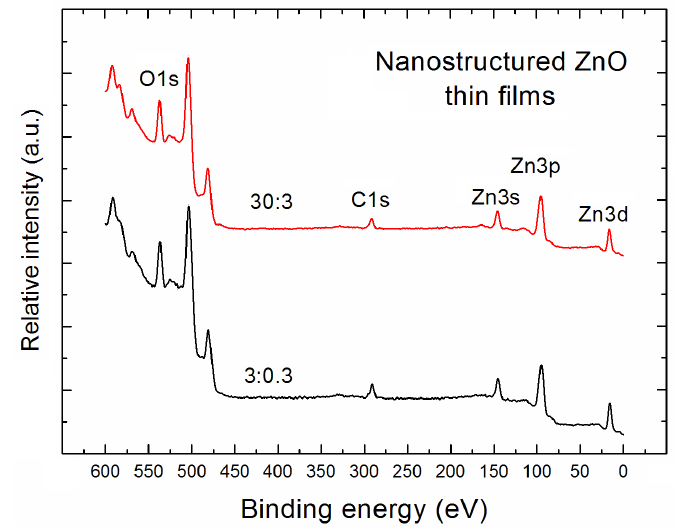
Figure 2. XPS survey spectra of nanostructured ZnO thin films deposited at the Ar/O 2 gas flow of 3:0.3 and 30:3 (in sccm), respectively.